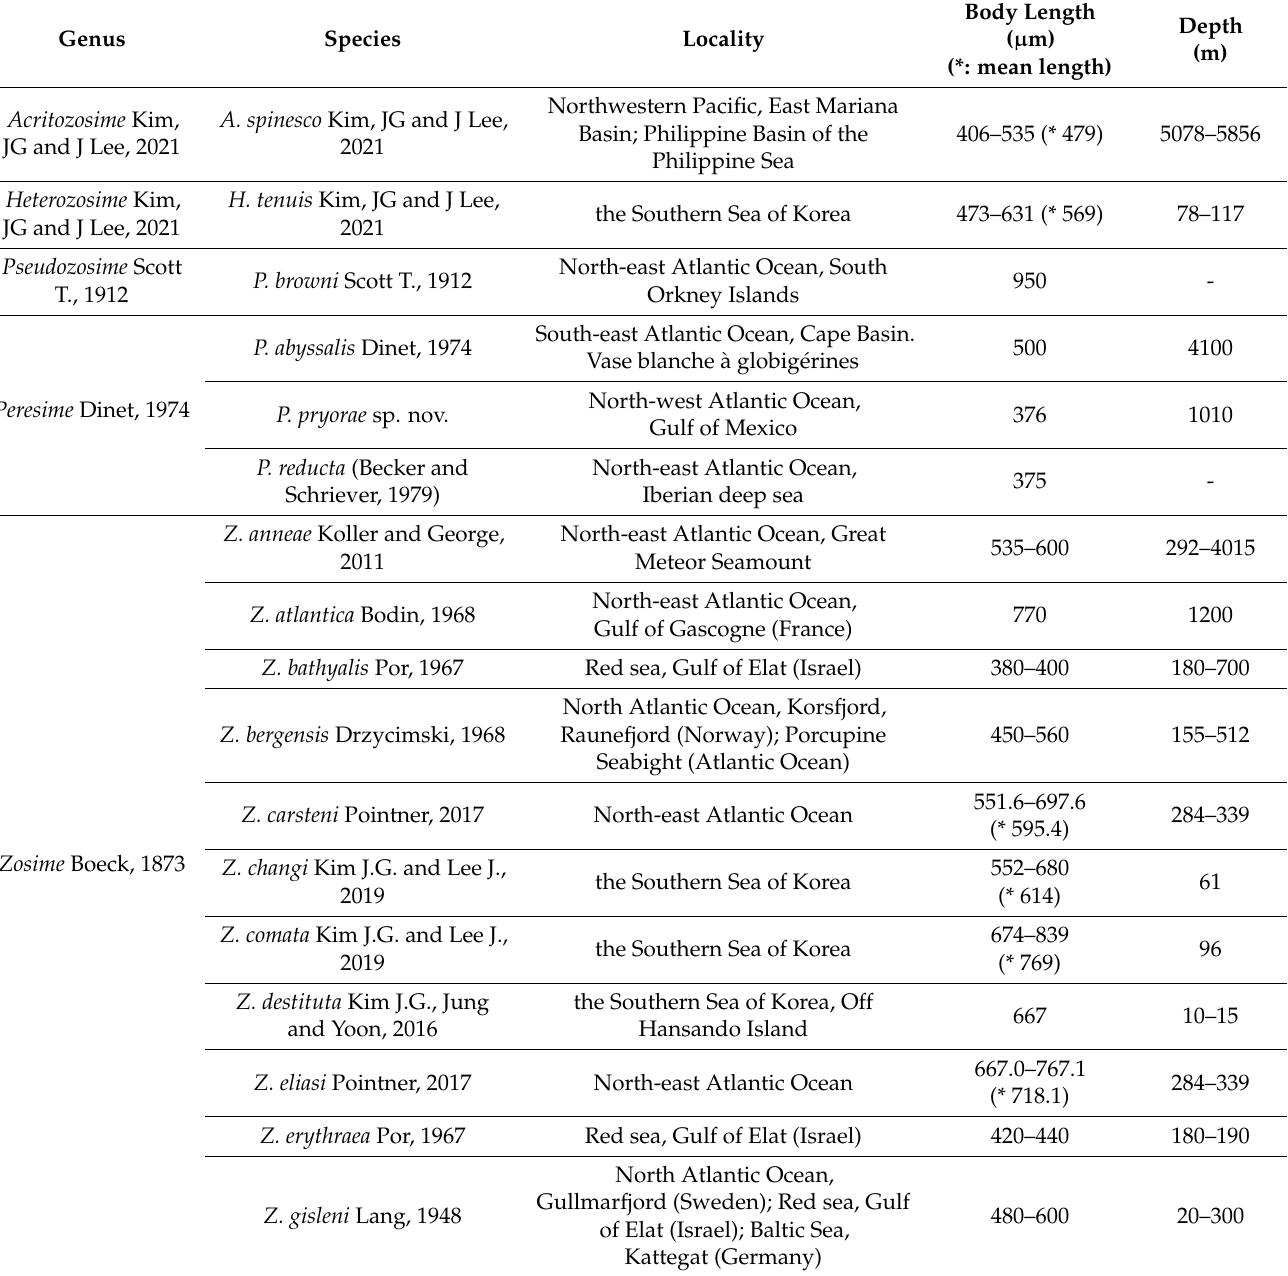
Table 5. Zosimeid species list. Z . rubra Thompson I.C., 1888 (nomen nudum), is not